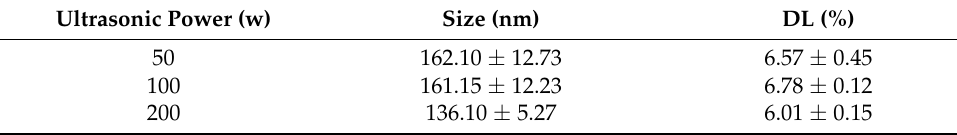
Table 5. Effect of ultrasonic power on DL.